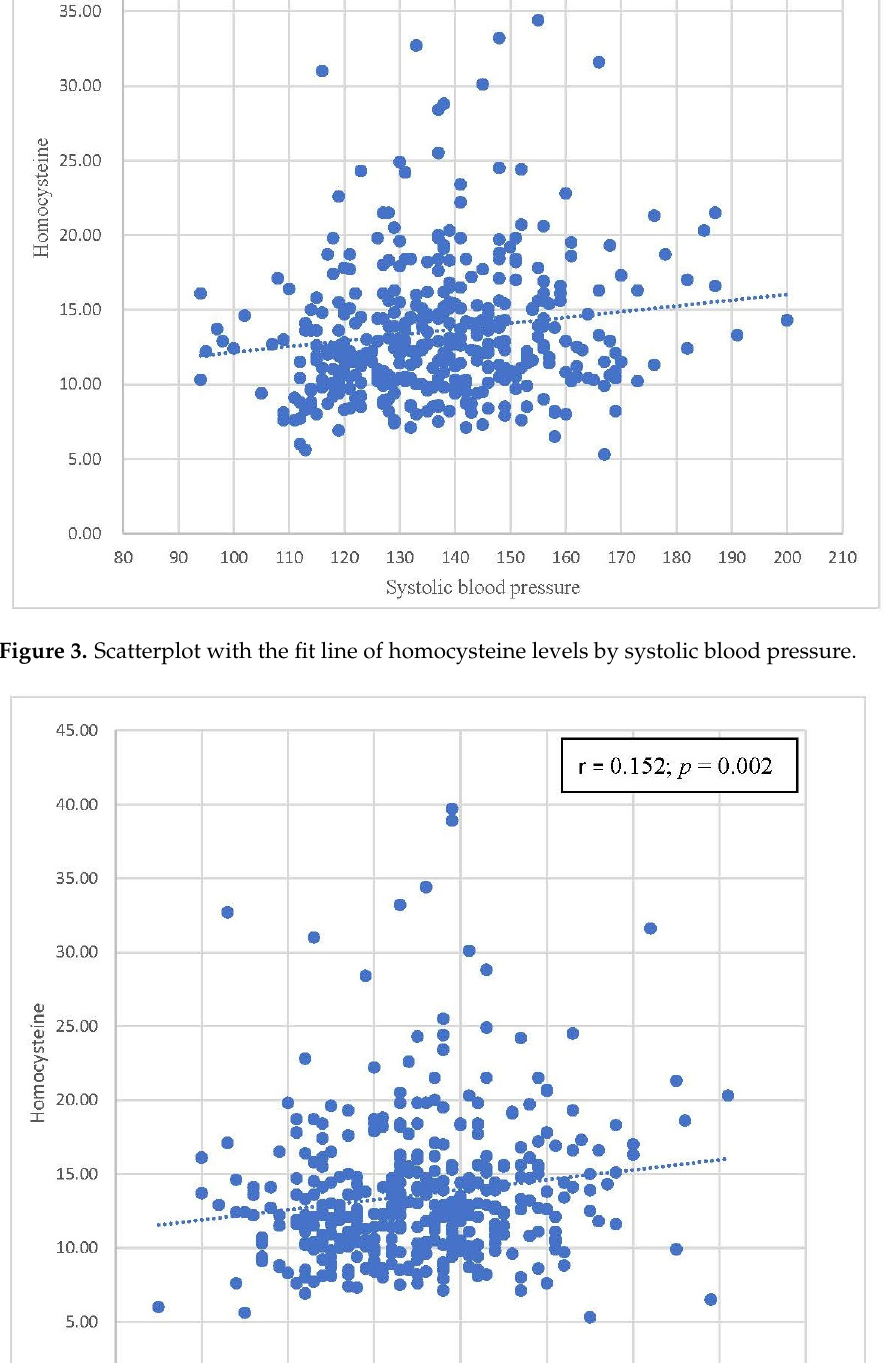
Figure 4. Scatterplot with the fit line of homocysteine levels by diastolic blood pressure.